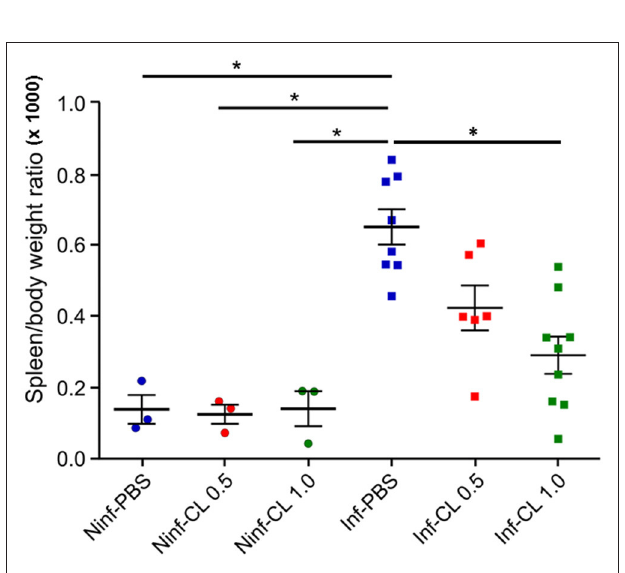
FIGURE 5 | Effect of P. falciparum infection and/or CL administration on spleen/body weight ratios. Solid lines represent the mean and standard deviation. * P <